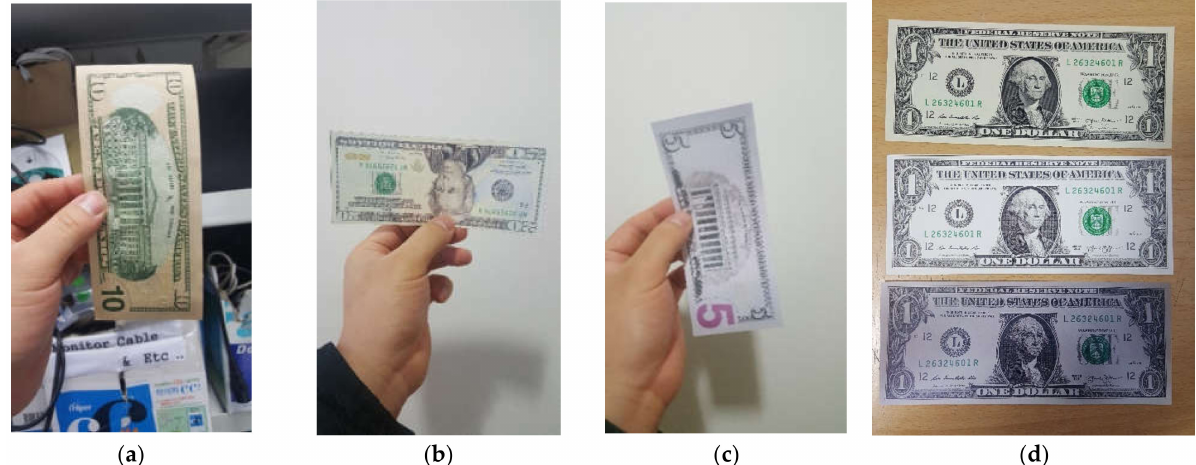
Figure 10. Examples of USD banknote images in the dataset: ( a ) genuine, ( b ) scanner-reproduced, ( c ) smartphone-reproduced, and ( d ) a group photo of the three types, from upper to lower: genuine, scanner-reproduced, and smartphone-reproduced.